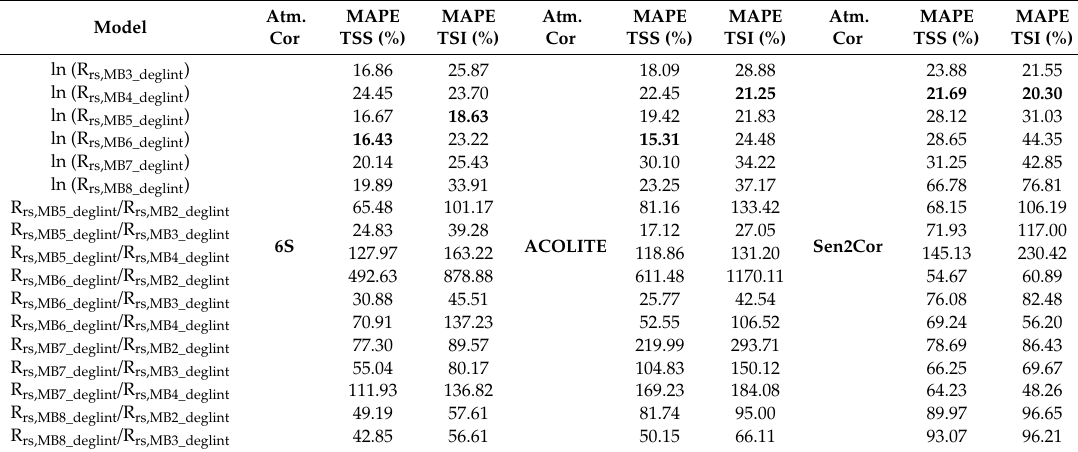
Table 5. The MAPE values (%) for empirical models applied to MSI atmosphere-corrected scenes after glint correction (6S, ACOLITE, and Sen2Cor). The R 2 and RMSE are in the Supplementary Files C. The bold values in each column refer to the best MAPE values (n = 14).